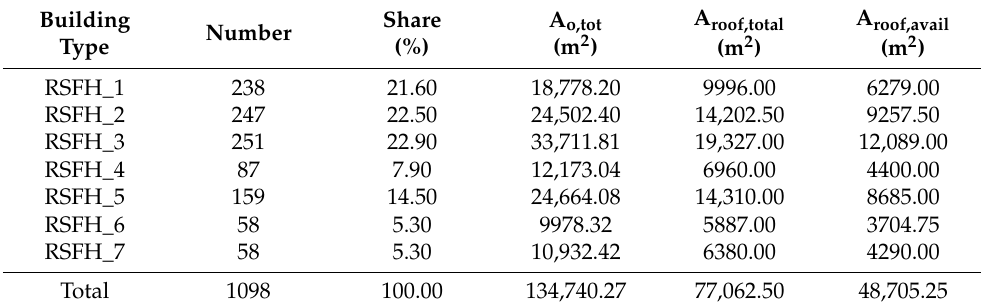
Table 3. Building distribution for the Nowosolna